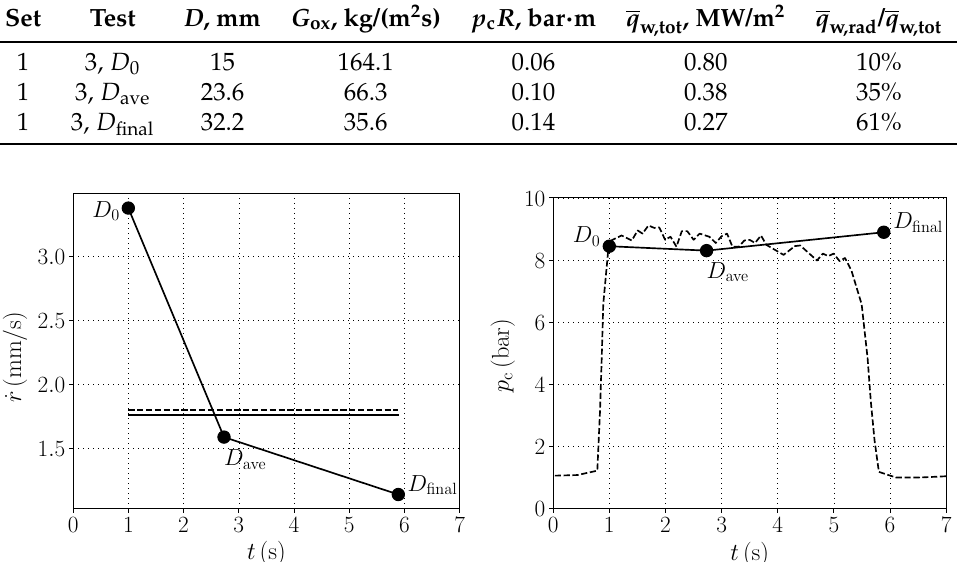
Table 5. Wall heat flux contributions on the grain surface for test 3 of set 1 at different port diameters.